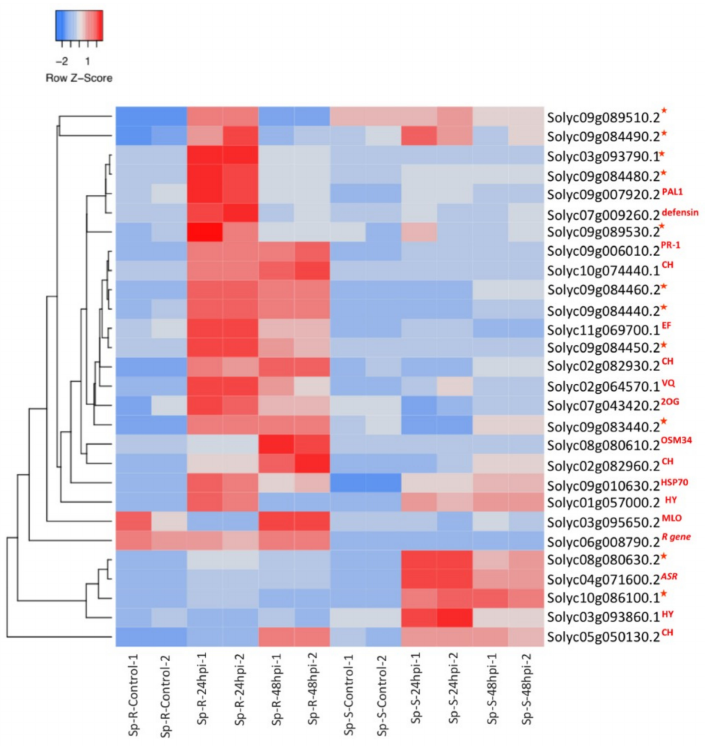
Figure 7. Heatmap showing expression profiles of core defense genes that could be putatively involved in resistance development against P. parasitica in Sp-R. Gradient scale is showing Z-scores of DEGs where red represents most induced expression and blue depicts highest repression. Gene identifiers with red stars on the right side are protease inhibitors. Other abbreviations used are: CH- chitinases, HY-hydrolases, VQ-VQ motif containing gene, 2OG-2OG-Fe oxygenase, EF-GTP binding Elongation factor Tu, OSM34-osmotin34, HSP70-heatshock protein 70, ASR- Abscisic acid stress ripening 5, PAL1-PHE ammonia lyase 1, and R gene-NB-ARC domain-containing disease resistance